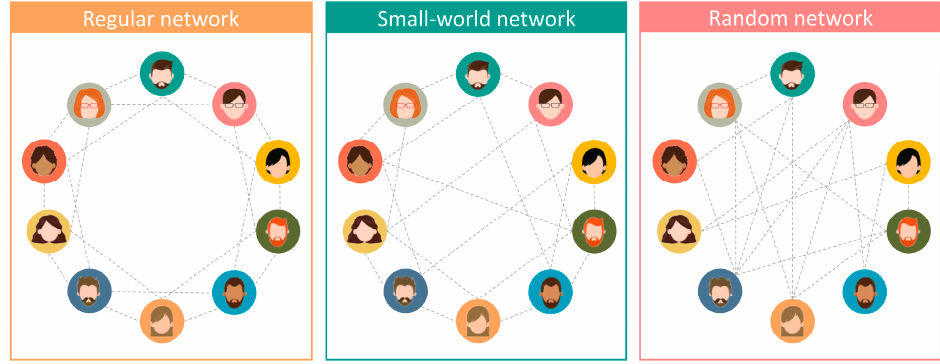
Figure 1. Regular, small-world, and random networks.